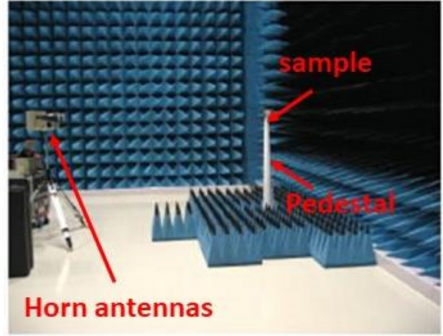
Figure 2. Reflection coefficient measurement setup.